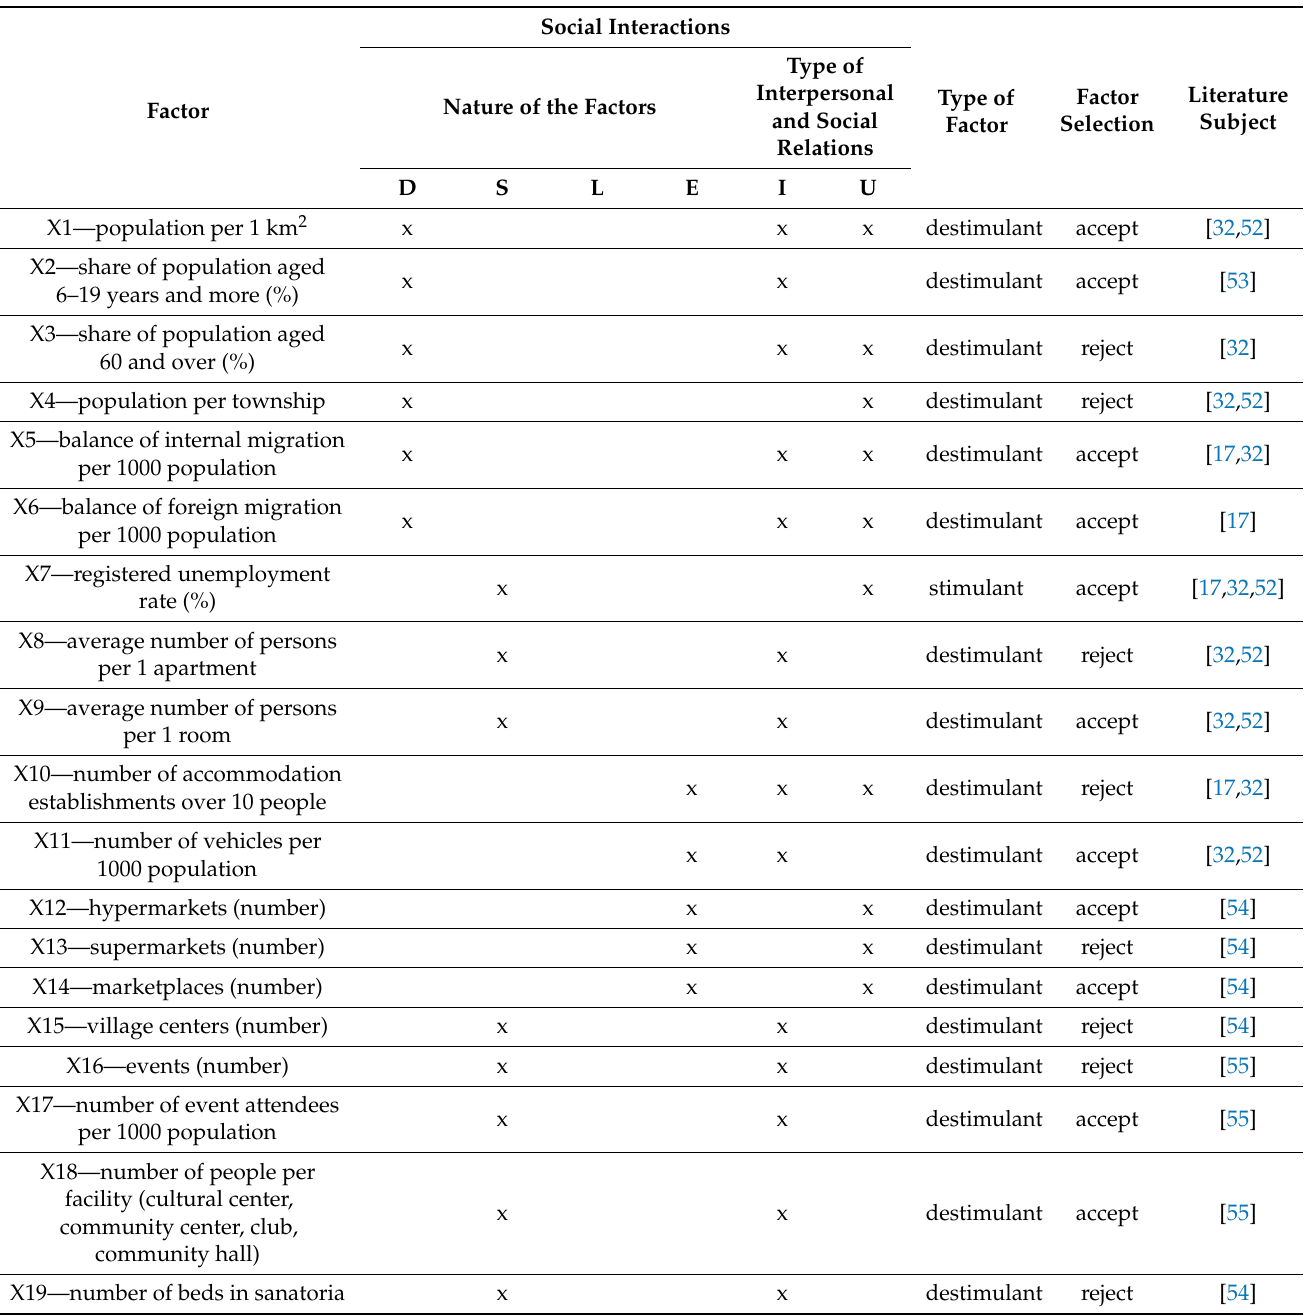
Table 1. Diagnostic factors for classifying areas vulnerable to epidemic